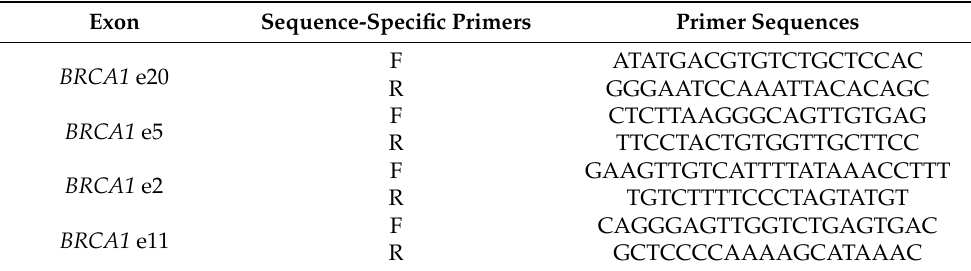
Table 1. The primer sequences used for BRCA1 founder mutations analysis by HRM-PCR and Sanger